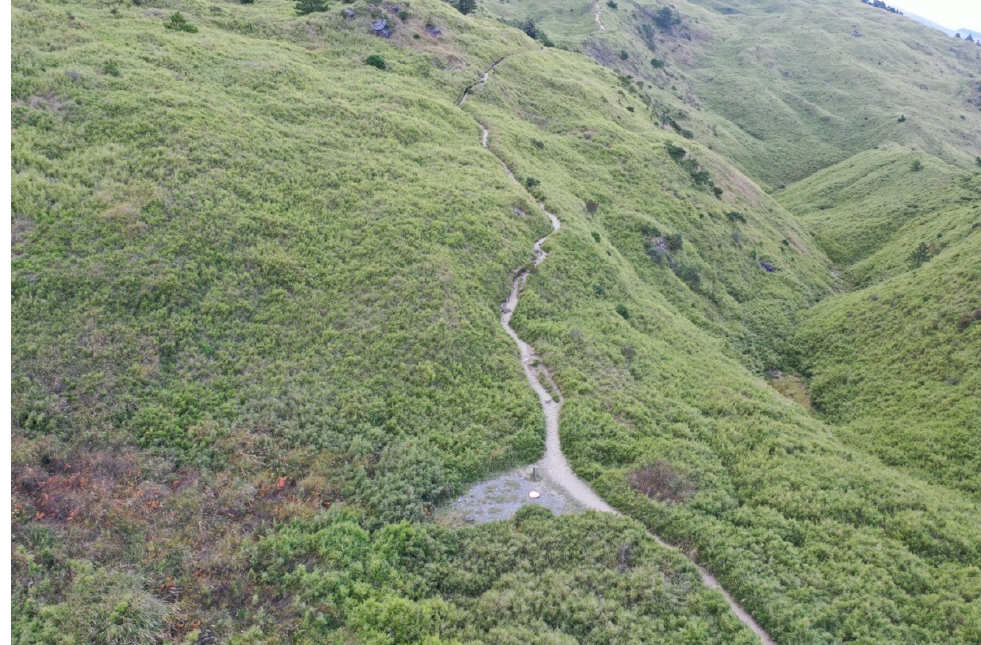
Figure 11. An informal campground set up beside the trail, east of Mt. Siao Qilai (3152 m), Mt. Qilai East Ridge Route in Taroko National Park. The park headquarters has tolerated informal campgrounds’ existence for emergency use (photo by drone, 13 October 2019).